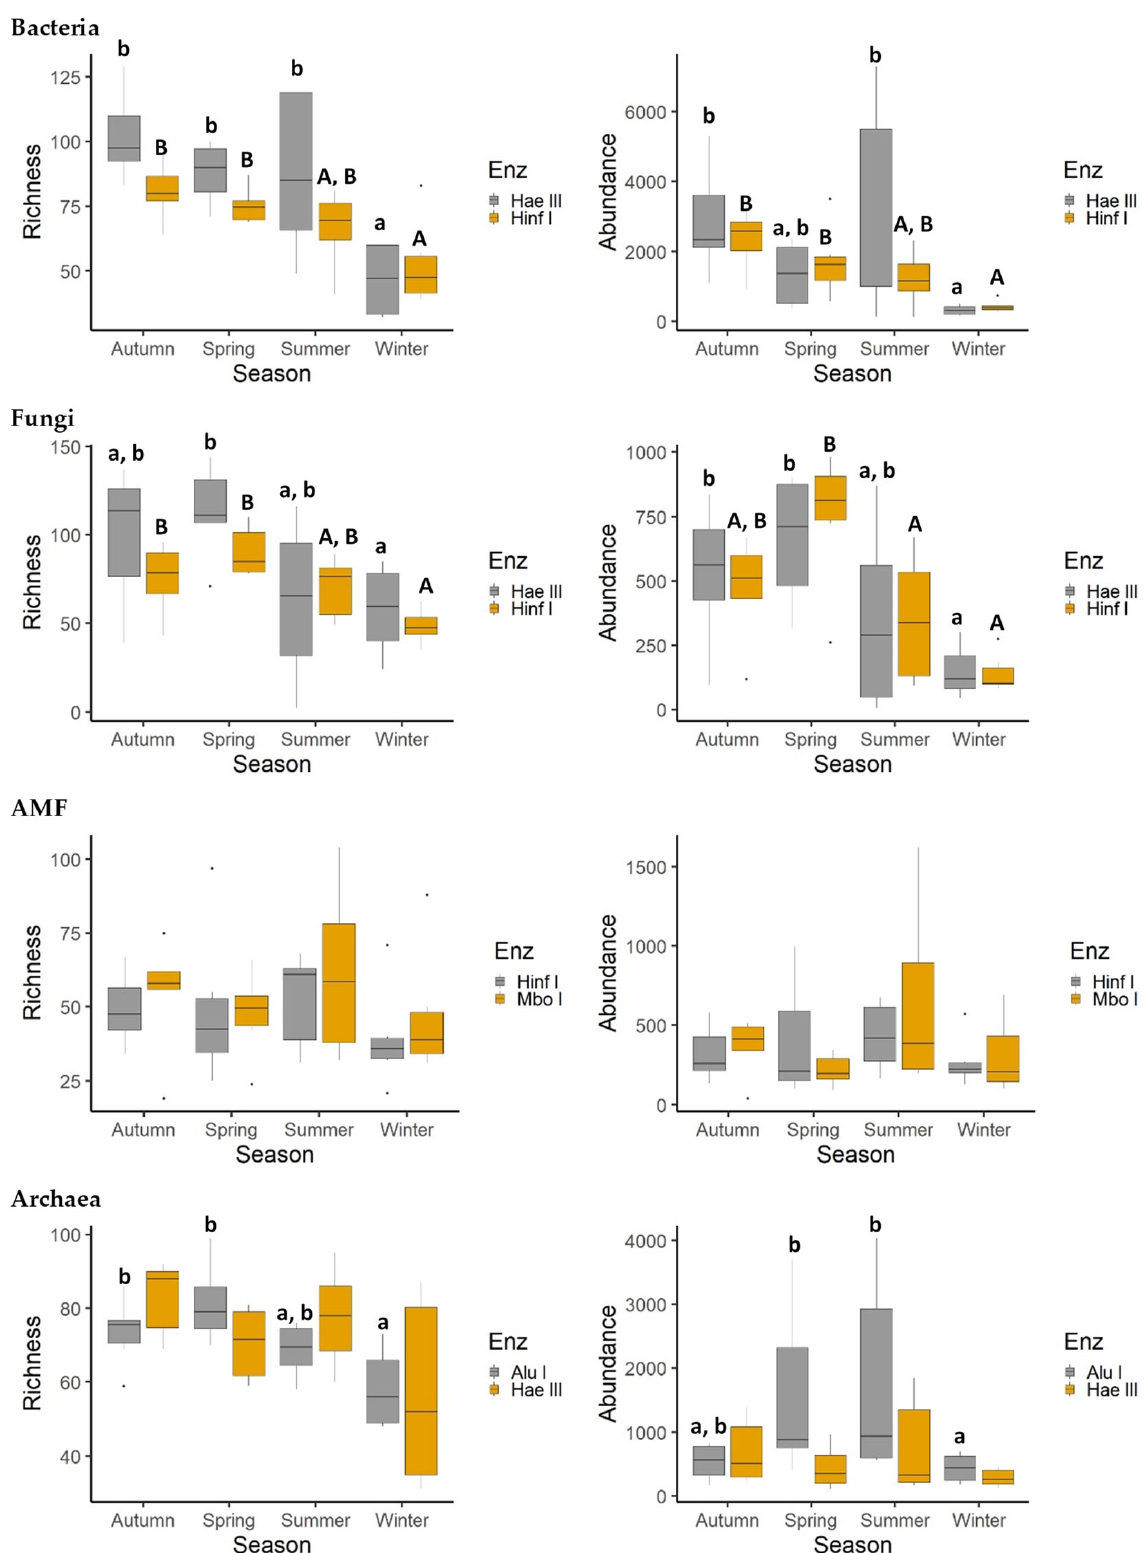
Figure 7. Variation in richness and abundance of Bacteria, Fungi, AMF, and Archaea, according to seasons. Boxes with different letters indicate a significant difference among them ( p ≤ 0.05). The letter a corresponds to the lowest values. Lowercase letters are for grey boxes and uppercase letters are for orange